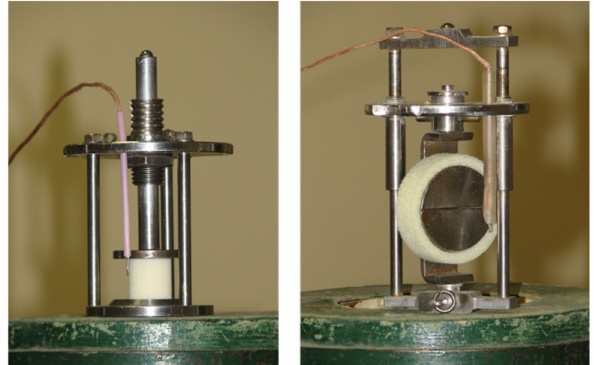
Figure 1. Appliance for samples for compression ( left ) and tensile ( right ) tests in 77 K.